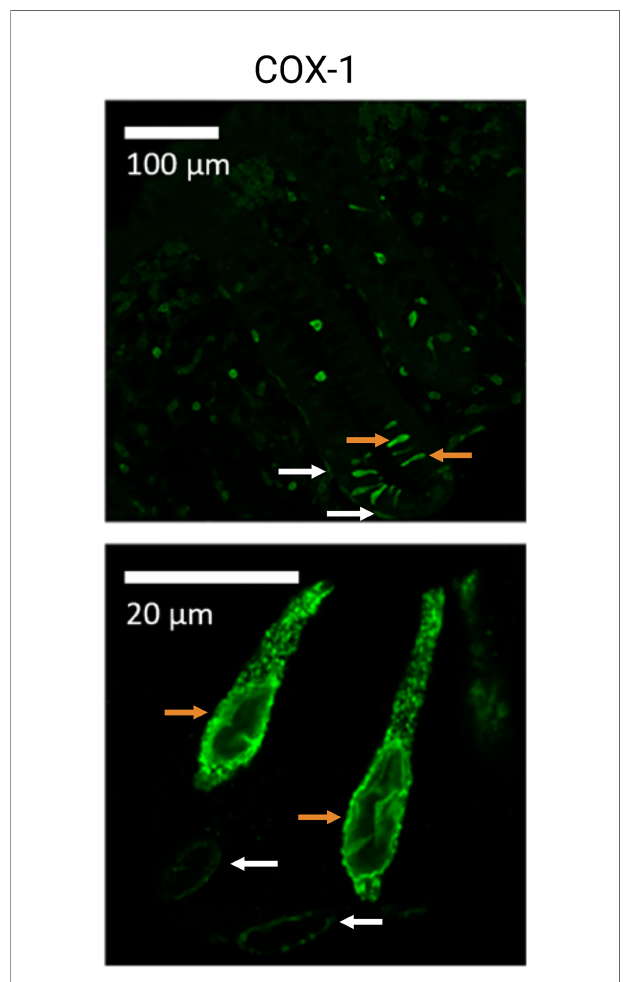
FIGURE 3 | Cyclooxygenase 1 (COX-1) positive tuft cells (TC) of the human colon. Illustration of colonic TCs from healthy human sigmoid biopsies (controls). Orange arrows indicate TCs, while white arrows indicate what could be interpreted as subepithelial/pericryptal fi broblasts. Adapted from “ Possible predisposition for colorectal carcinogenesis due to altered gene expressions in normal appearing mucosa from patients with colorectal neoplasia ” by Petersen et al.